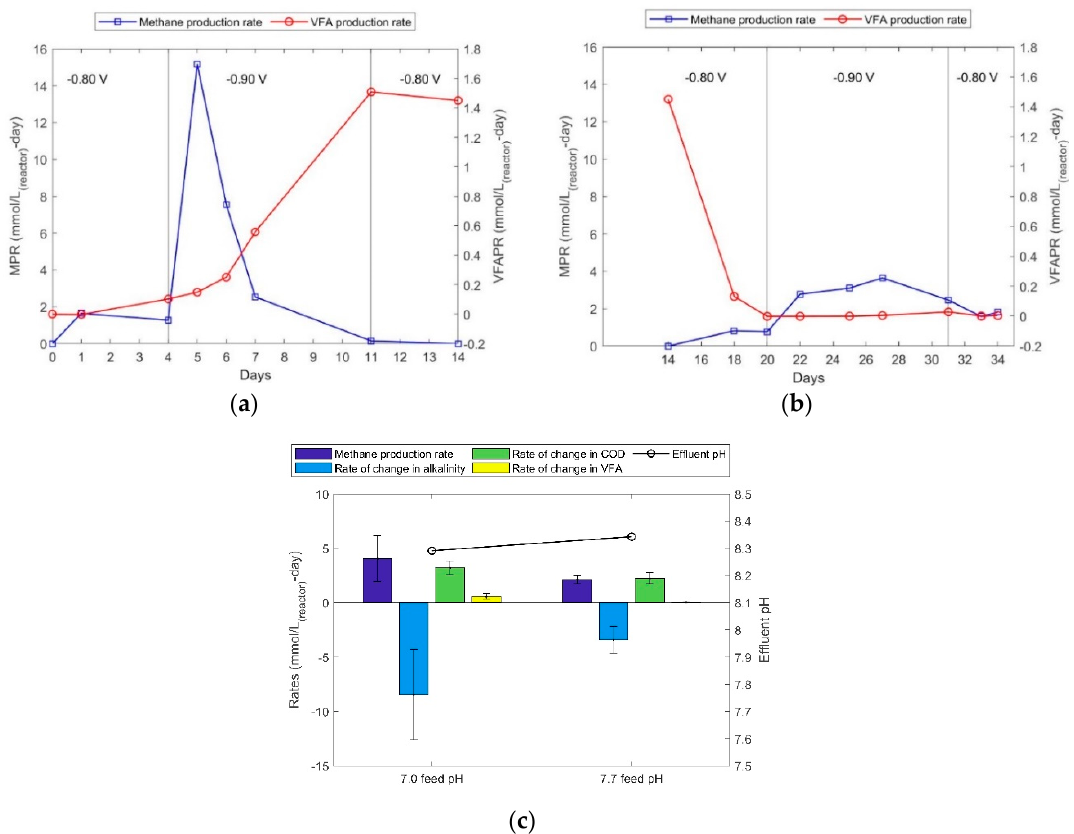
Figure 2. ( a ) Methane and VFA production rates at low feed pH. ( b ) Methane VFA production rates at high feed pH. ( c ) Yields of di ff erent parameters at di ff erent feed